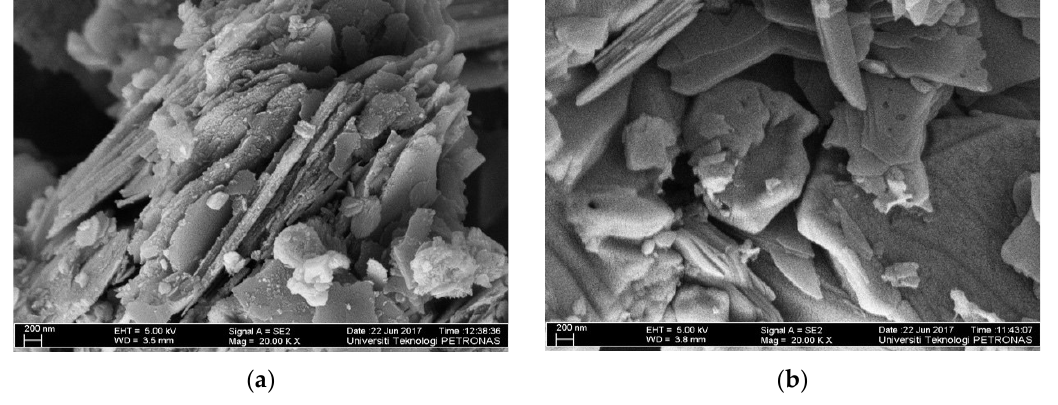
Figure 4. FE-SEM images for ( a ) BG-2 and ( b ) KH-2 shales. The Energy-Dispersive X-Ray (EDX) spectra for BG-2 (a) and KH-2 (b) shales is shown in Figure 5 with a corresponding miniature image of Figure 4 embedded in the graph for ease of comparison.